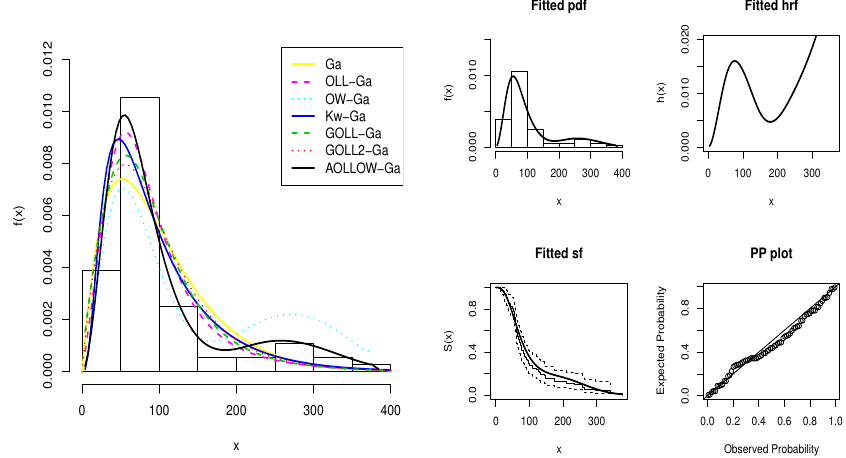
Figure 9. The fitted plots for the second